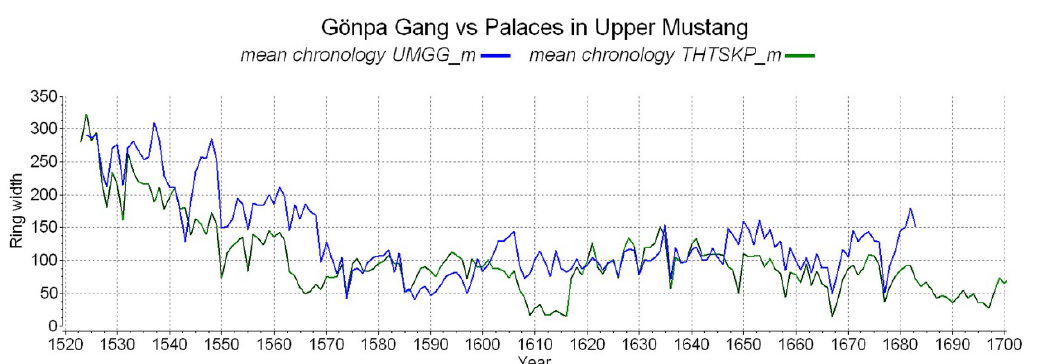
Figure 12. Visual cross-matching of the chronology representing timber from Gönpa Gang: UMGG_m (blue curve) with the chronology developed from timber found in Tsarang Palace and Thinggar Palace in Upper Mustang [37] in green. Only the overlapping period of the two chronologies is presented here. (TSAP-Win [48]).